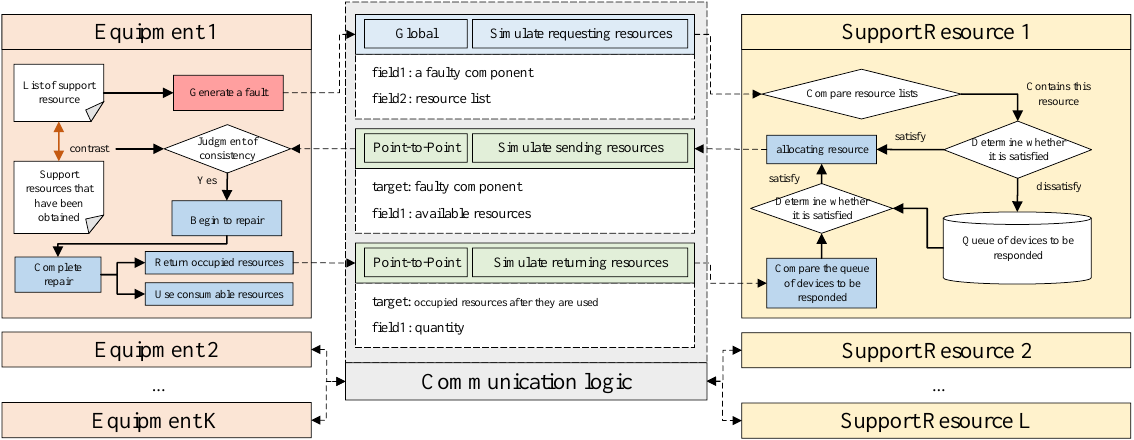
Figure 10. Communication logic between equipment agent and support resource agent.